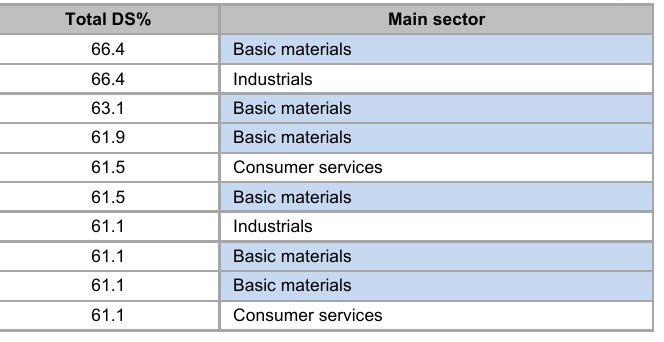
Top 10 online IR sites of South African listed companies per